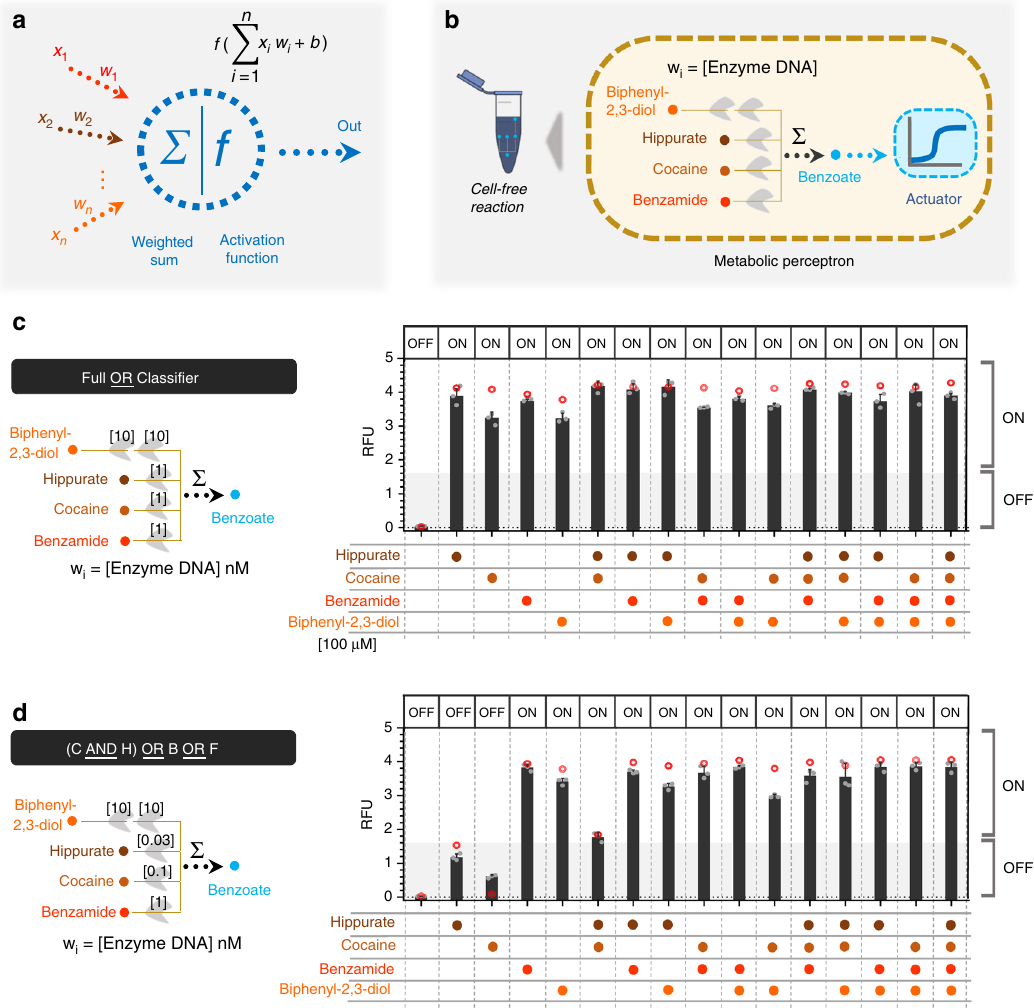
Fig. 6 Cell-free perceptron enabling development of classi fi ers. a A perceptron scheme showing the inputs and their associated weights, the computation core, and the output. The perceptron computes the weights and actuates the weighted sum through an activation function. b Metabolic perceptron integrating multiple inputs and actuating an output. The benzoate actuator acts as the activation function of the perceptron reporting the sum of benzoate produced by the metabolic perceptron. Hippurate, cocaine, benzamide, and biphenyl-2,3-diol are the inputs of the metabolic perceptron fi xed to 100 µ M. The weights of the perceptron are the concentration of the enzymes calculated using the model made on weighted metabolic circuits (red circles). These weights are calculated to develop two classi fi ers using the metabolic perceptron and benzoate actuator. Full OR classi fi er c , [cocaine (C) AND hippurate (H)] OR benzamide (B) OR biphenyl-2,3-diol (F) classi fi er ( d ) are the two classi fi ers built using this metabolic perceptron. The Full OR classi fi er ( c ) classi fi es to OFF when none of the inputs is present and it passes an arbitrary threshold to ON when any of the inputs or their combinations are present. The second classi fi er ( d ) performs a more complex computation. The shading represents the arbitrary threshold that allows for perceptron decision making and the panel of OFF and ON at the top of the bars are the expected output of the classi fi ers. All data are the mean and the error bars are the standard deviation of normalized values from three measurements and red circles are the model predictions (gray dots on each bar are individual values from which the mean and SD were calculated). (RFU relative fl uorescence unit). Source data are provided in the Source Data fi